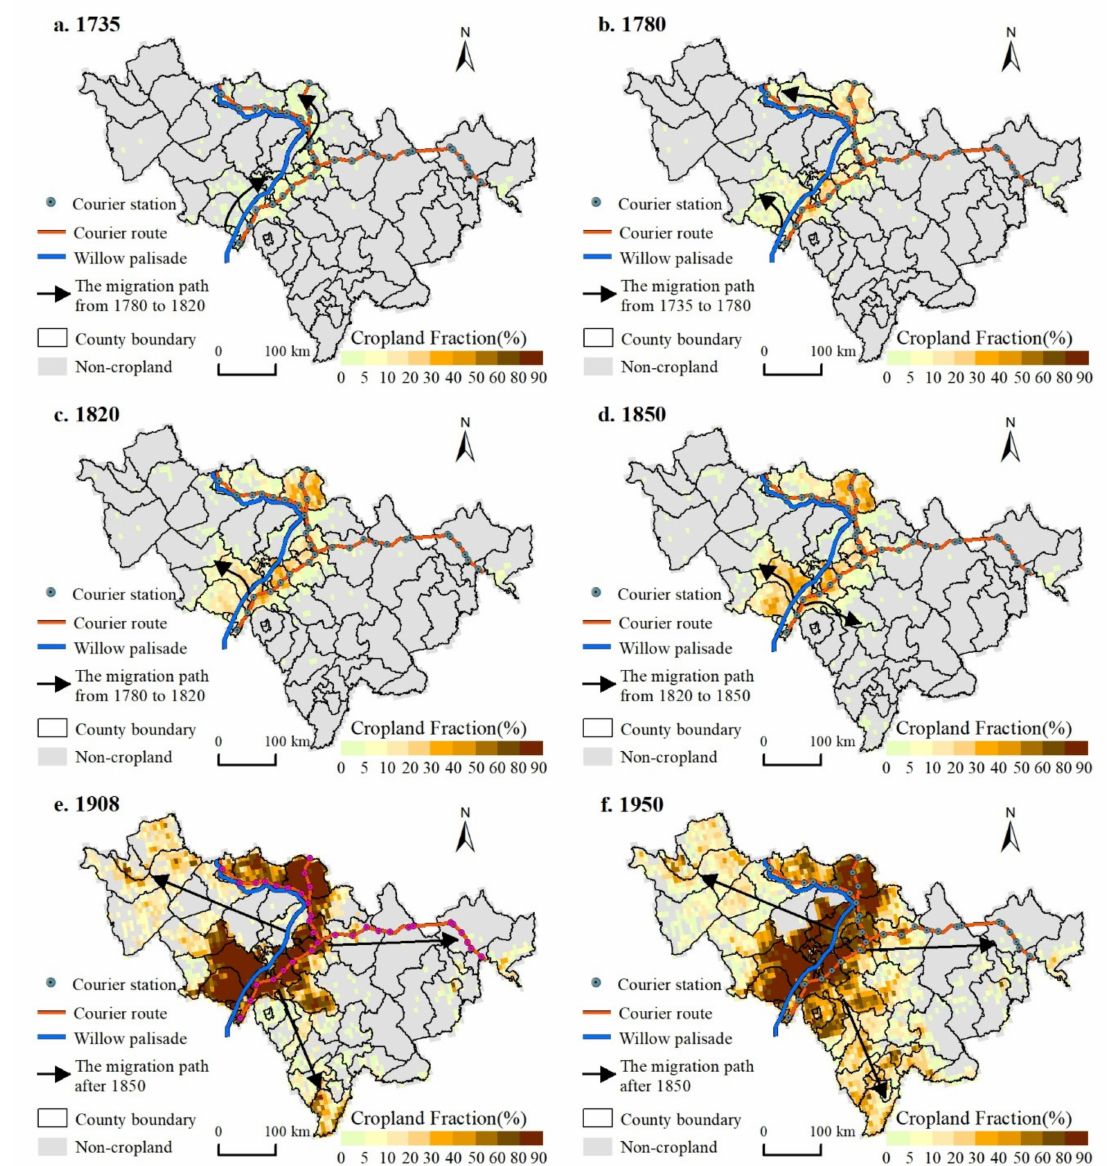
Figure 7. The spatial distribution of 5 (cid:48) × 5 (cid:48) cropland cover in Jilin Province allocated using the settlement density